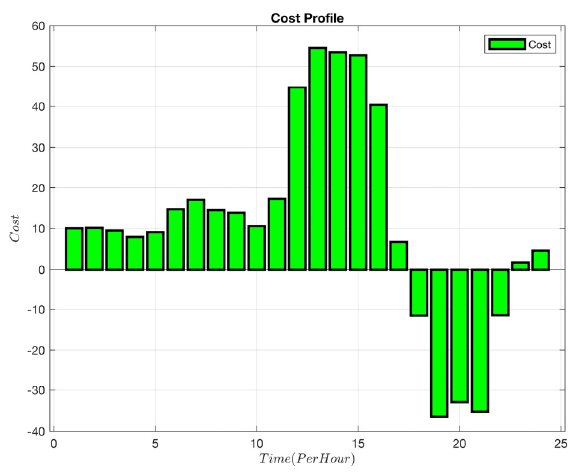
Figure 8 . MG cost profile . Figure 8. MG cost profile.